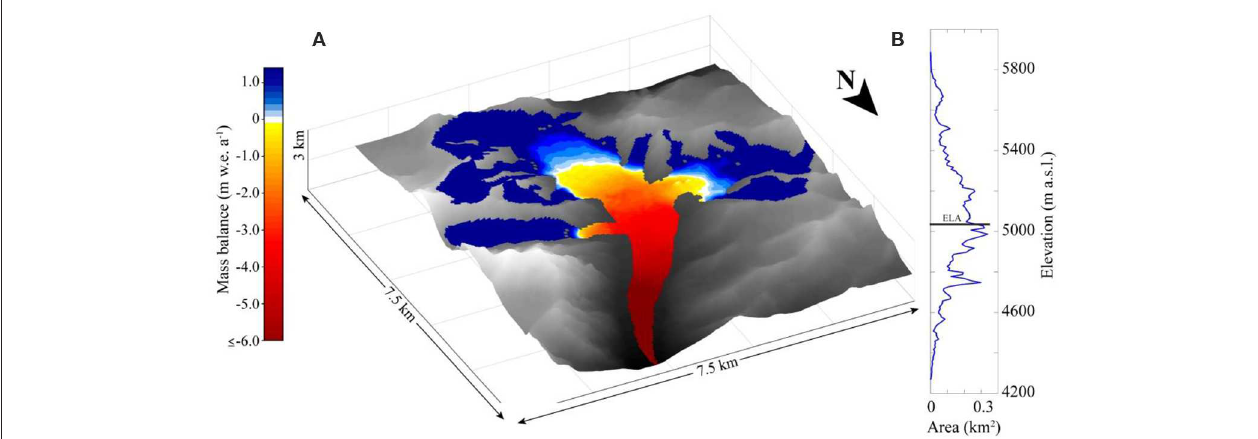
FIGURE 2 | The selected glacier for this study is north facing and is ∼ 16 km 2 . (A) The colors show the extent of the glacier and results of modeled mass balance across the glacier for the control run, with the white areas being the ELA. The spatial resolution is 30m. (B) Area distribution vs. elevation for the selected glacier, summed over 10m elevation bands. The ELA is approximated by the black